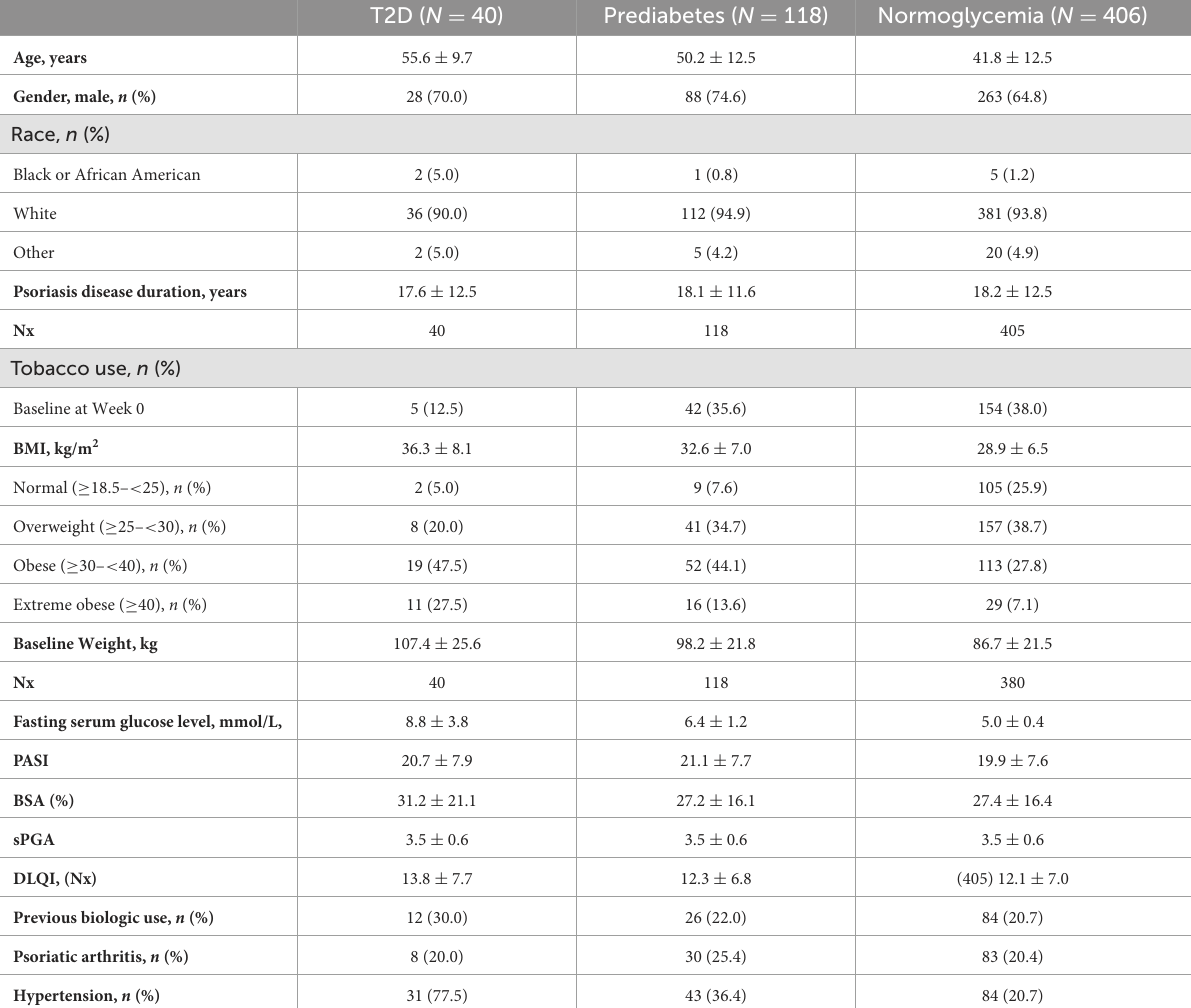
TABLE 1 Baseline patient demographics and characteristics in ixekizumab-treated patients included in this post-hoc analysis. T2D ( N = 40) Prediabetes ( N =